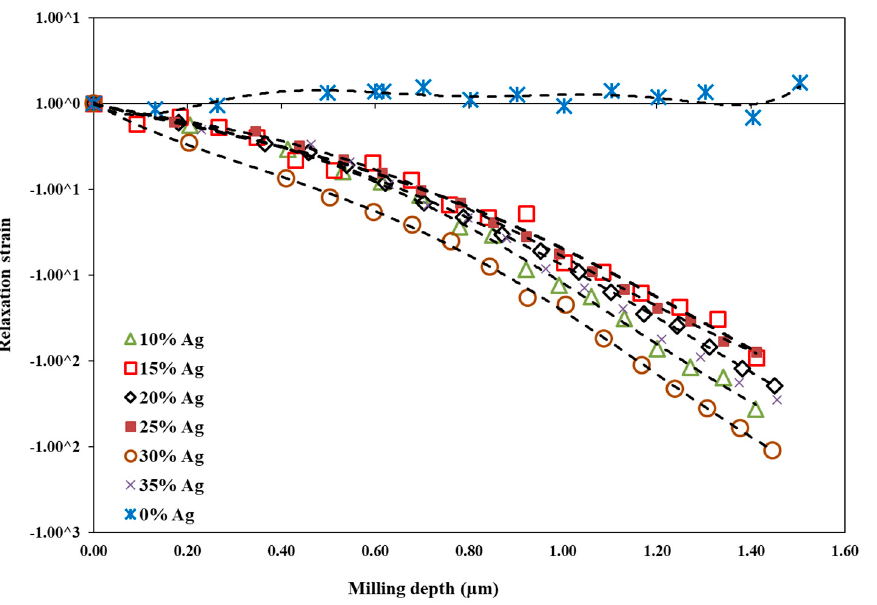
Figure 9. The relaxation strain determined by the focused ion beam and digital image correlation (FIB-DIC) method for Ti-Cu and Ti-Cu-Ag thin films with a various Ag content as a function of the milling depth.